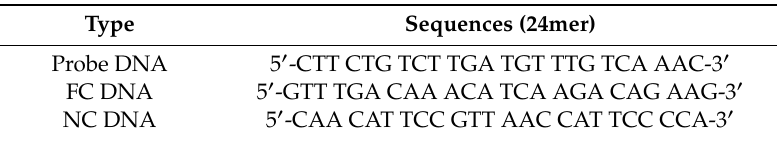
Table 1. All the DNA used in this